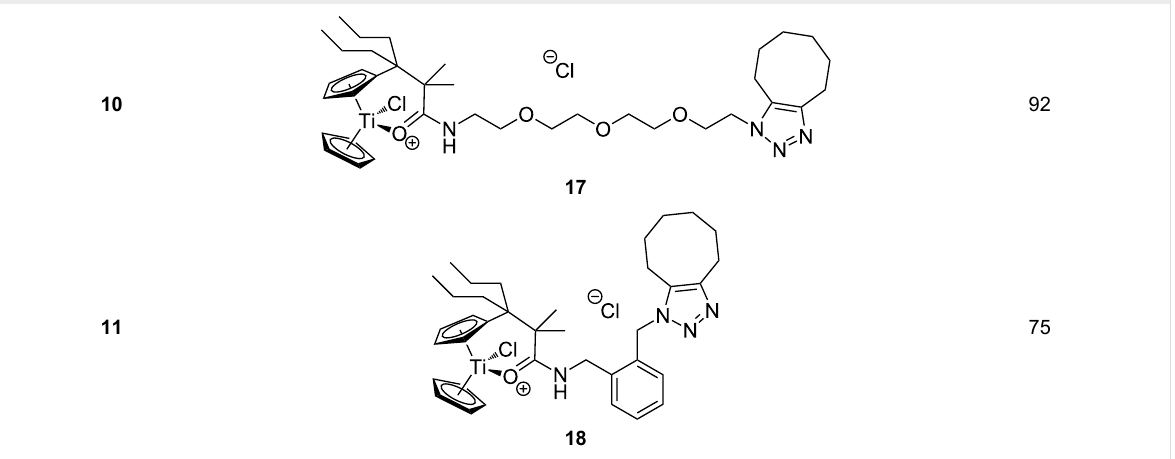
Table 2: Strain-driven 1,3-dipolar cycloadditions between cyclooctyne and azide-functionalized titanocenes in CH 2 Cl 2 (0.1 M). (continued)